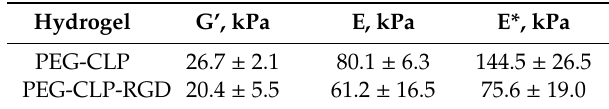
Table 1. Elastomechanical properties of crosslinked peptide hydrogels. Shear storage modulus (G’) was estimated by rheology and was used to calculate the Young (elastic) modulus (E). Direct and detailed probing of the Young moduli (E*) was performed by the atomic force microscopy nanoindentation technique, and the values for PEG-CLP compared to PEG-CLP-RGD had a statistically significant difference, p ≤ 0.05.